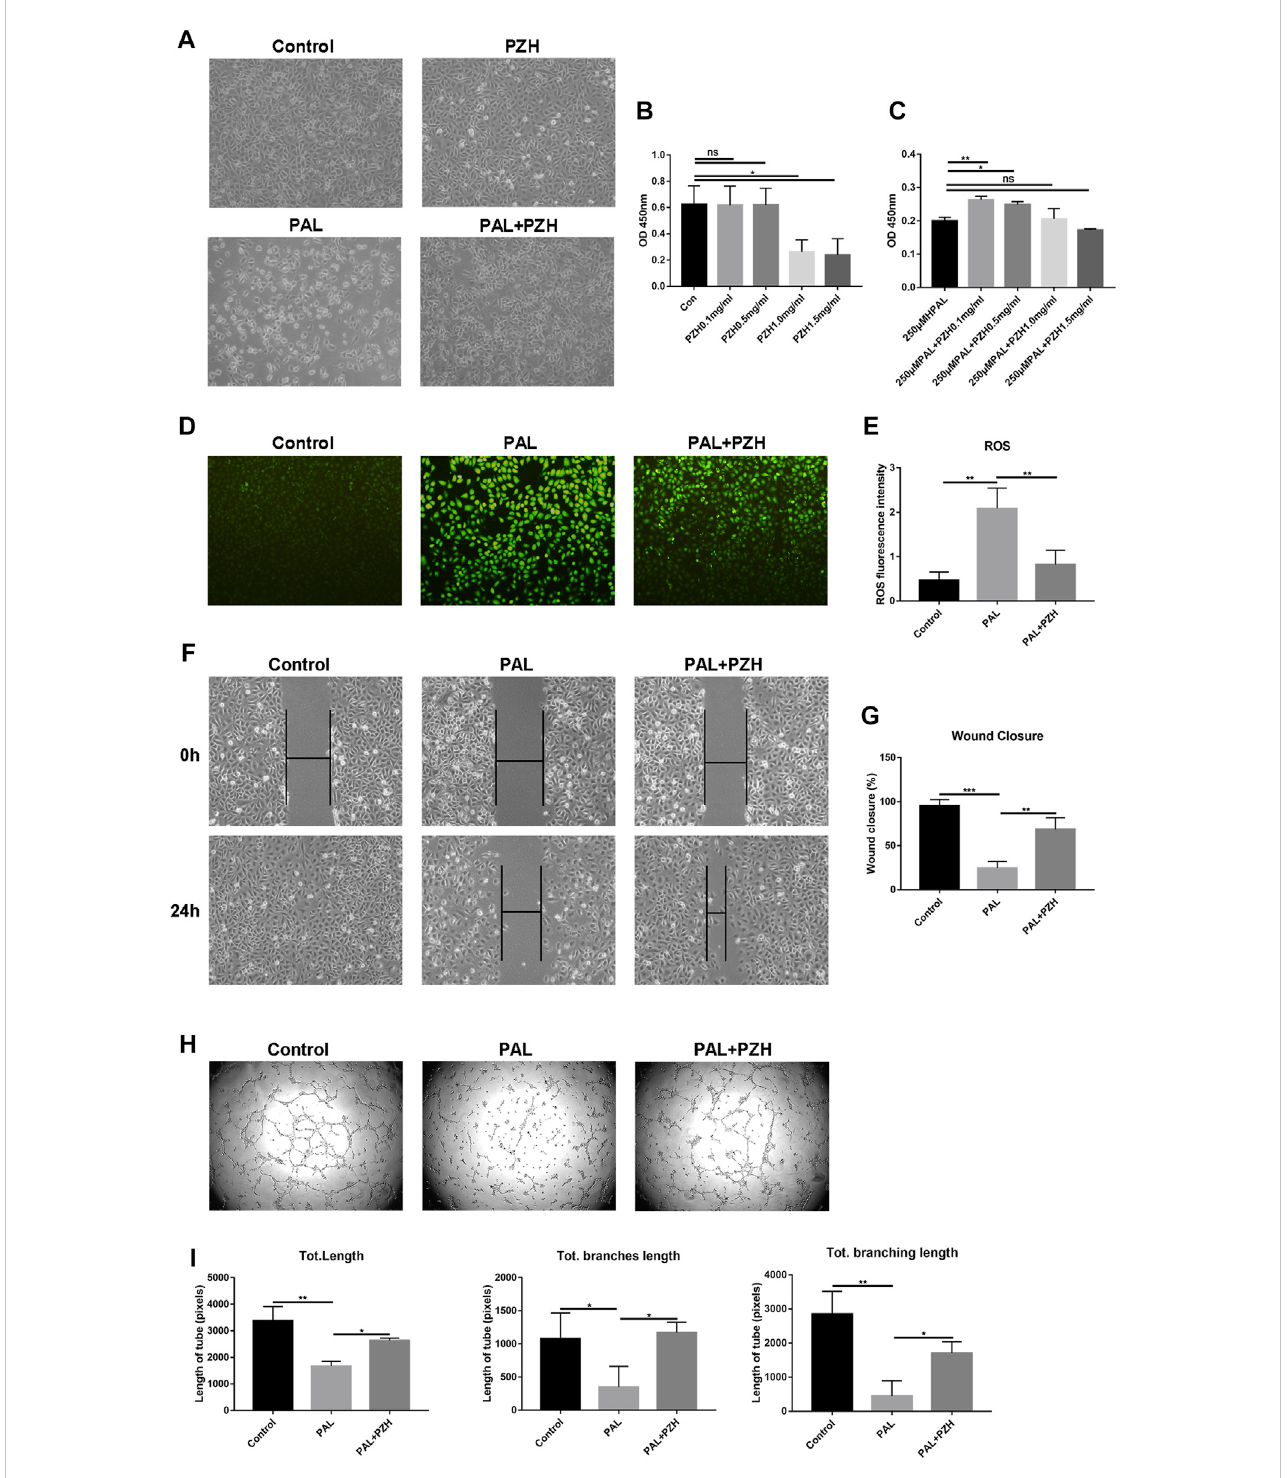
FIGURE 5 PZH protects HUVECs from impaired function in PAL. (A) The effects of PZH (0.1 mg/mL) on the cell growth status of HUVECs after exposure to PAL (250 μ M) for 24 h (B,C) The proliferation was detected by CCK8 kits in HUVECs at different concentrations of PZH intervention for 24 h without (B) or with 250 μ MPALintervention (C) .* p < 0.05,** p < 0.01 (n=3). (D,E) TheeffectsofPZHonantioxidative stressinHUVECsafterexposuretoPAL (D) byusingDCFH- DA staining to detect the ROS level, the fl uorescent intensity (E) was quanti fi ed by ImageJ ** p < 0.01, (n = 3). (F – G) The effects of PZH on HUVECs migration (F) wasassessedat0and24 hfollowingcell-scratching.Thewoundclosurerate (G) wasquanti fi edbyImageJ.** p < 0.01,*** p < 0.001(n=3). (H – I) The effects of PZH on the angiogenic function (H) of HUVECs were determined by tube formation assay. The tube length (I) was quanti fi ed by ImageJ. * p < 0.05, ** p < 0.01 (n =